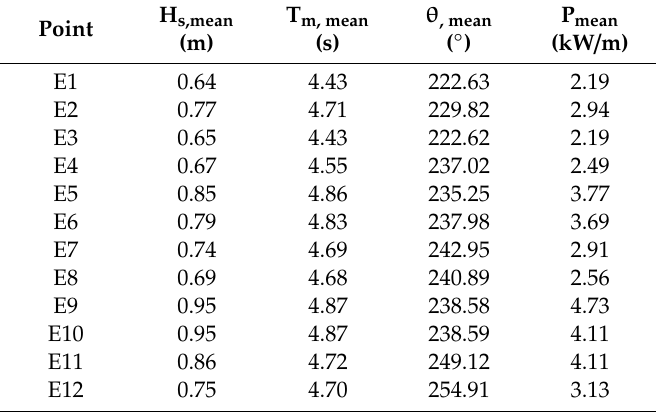
Table 4. Main wave climate parameters (based on 39-year average) at ECMWF grid points.